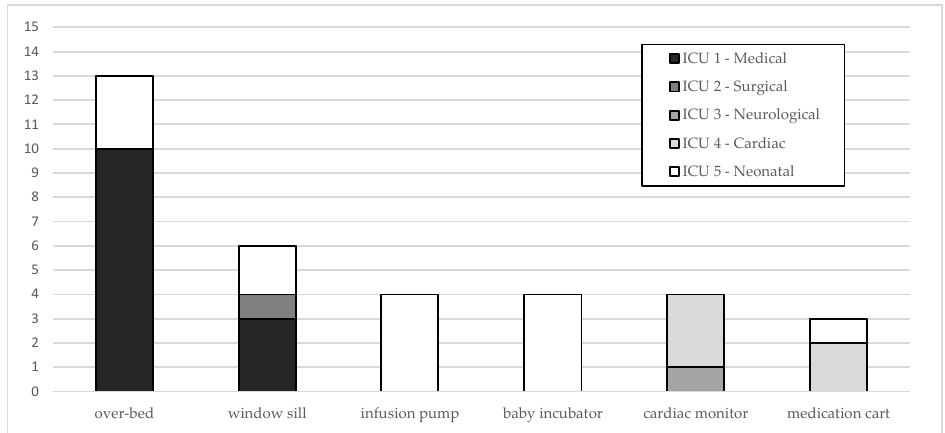
Figure 4. Distribution of samples > 500 CFU/100 cm 2 by surfaces and ICUs.